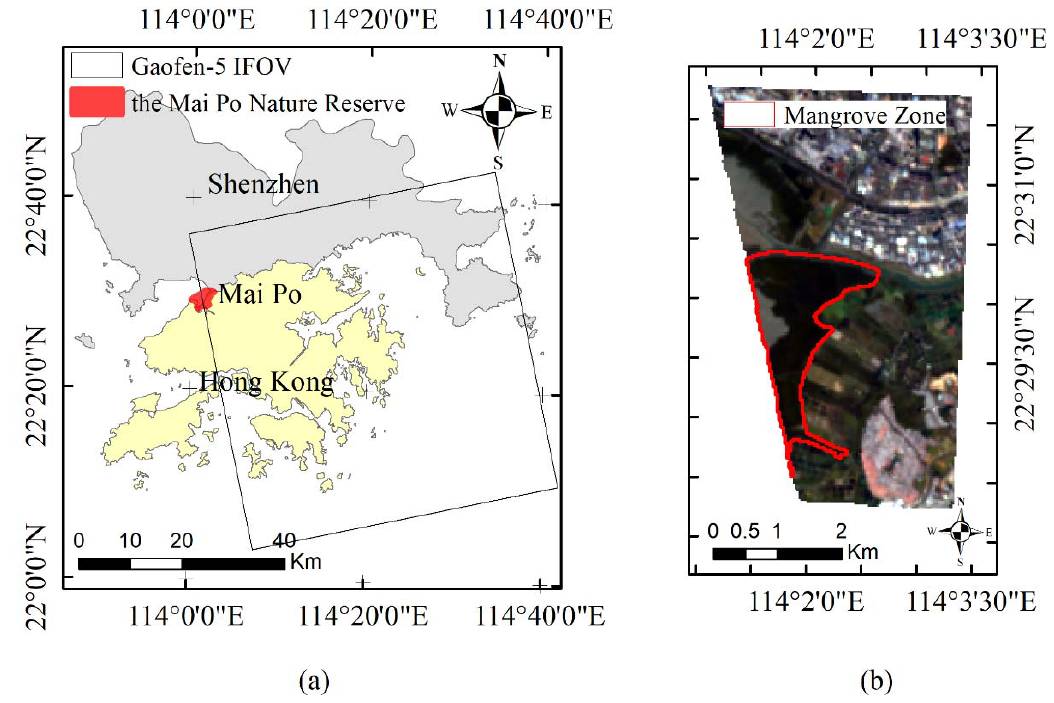
Figure 1. The geographical location of the Mai Po Nature Reserve (MPNR, with red polygon) and Gaofen-5 instantaneous field of view (IFOV, in black rectangle) covering part of the Reserve ( a ), a scene of Gaofen-5 hyperspectral image was cropped to cover the Reserve (Red = 698.166 nm, Green = 544.196 nm, Blue = 437.193 nm) and the mangrove zone was outlined with a red polygon ( b ).